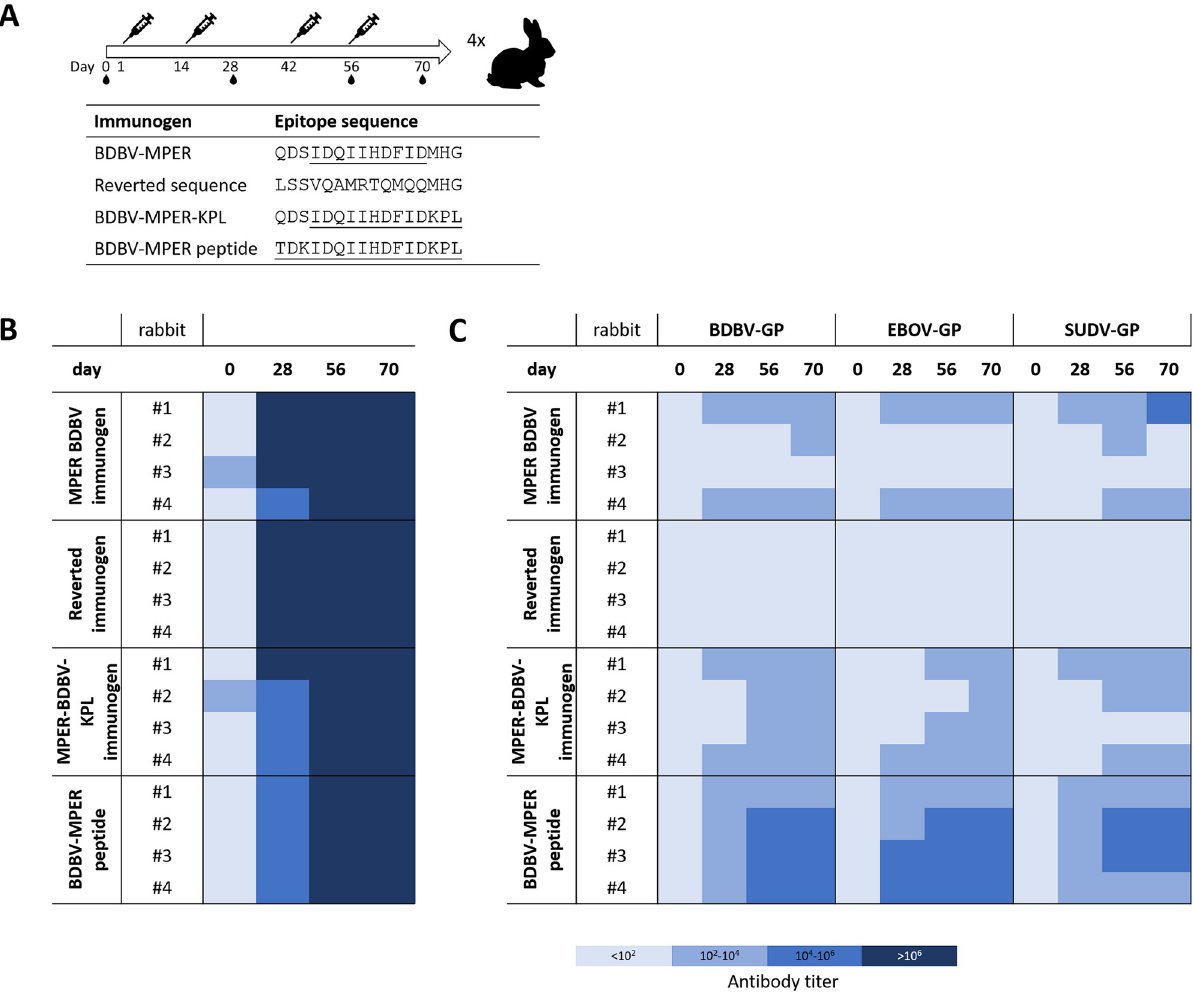
Fig 4. Serum binding from rabbits immunized with BDBV-MPER immunogens. (A) Immunization study set-up. Prime immunization, and three boosts were administered with 0.5 mg and 0.25 mg antigen, respectively. For prime immunization Complete Freund’s Adjuvant was used, while Incomplete Freund’s Adjuvant was used for boost immunizations. Blood was drawn on days 0, 28, 56, 70. (B) Serum binding titers to antigens used for immunization shows high titers for the nanoparticle formulation. (C) Serum binding titers for BDBV, EBOV, or SUDV GPs as determined by ELISA